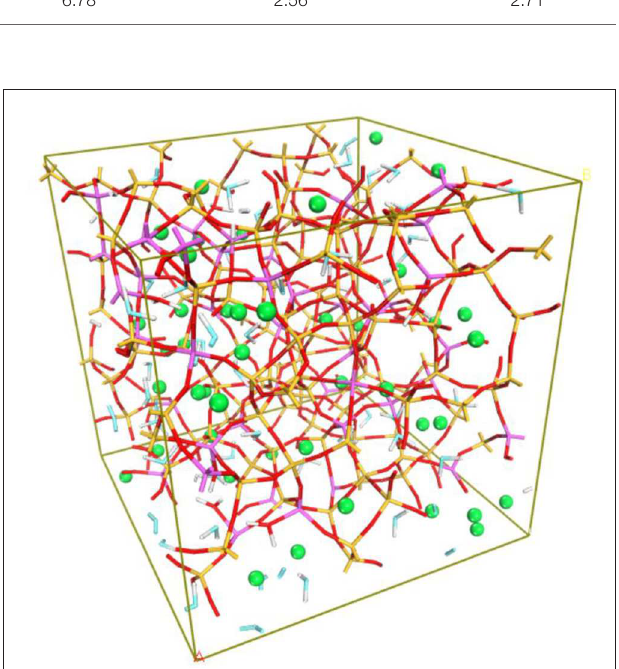
FIGURE 1 | N-A-S-H gel model. Yellow-red sticks represent the Si-O bond; purple-red sticks stand for the Al-O bond; red-white sticks are the hydroxyls attached to Si or Al; blue-white sticks are the OH of water molecules; green balls represent Na.